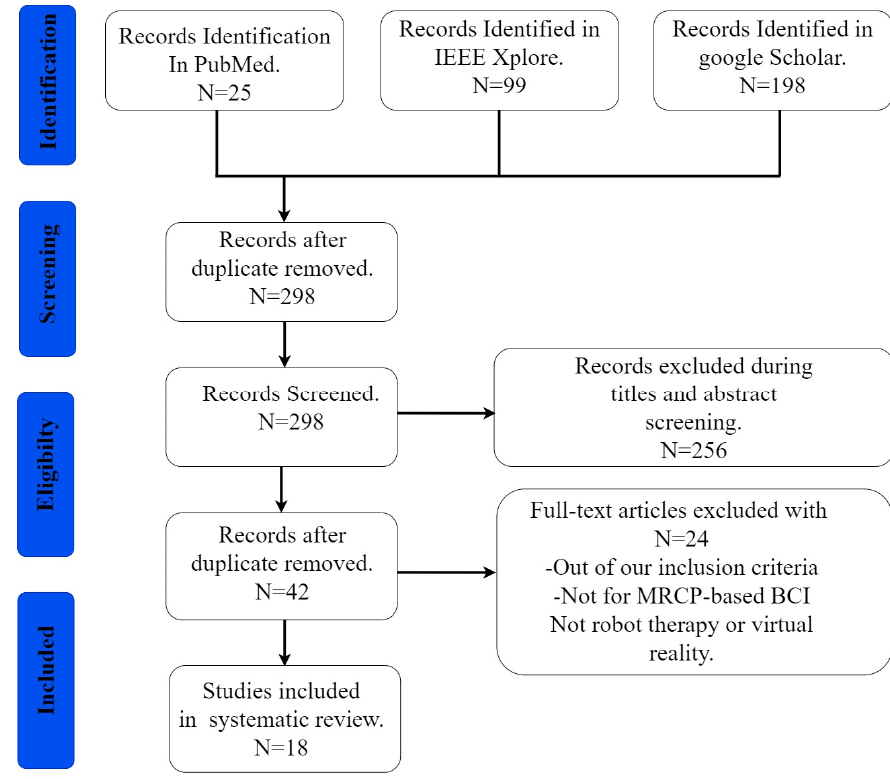
Figure 3. PRISMA flowchart of the present